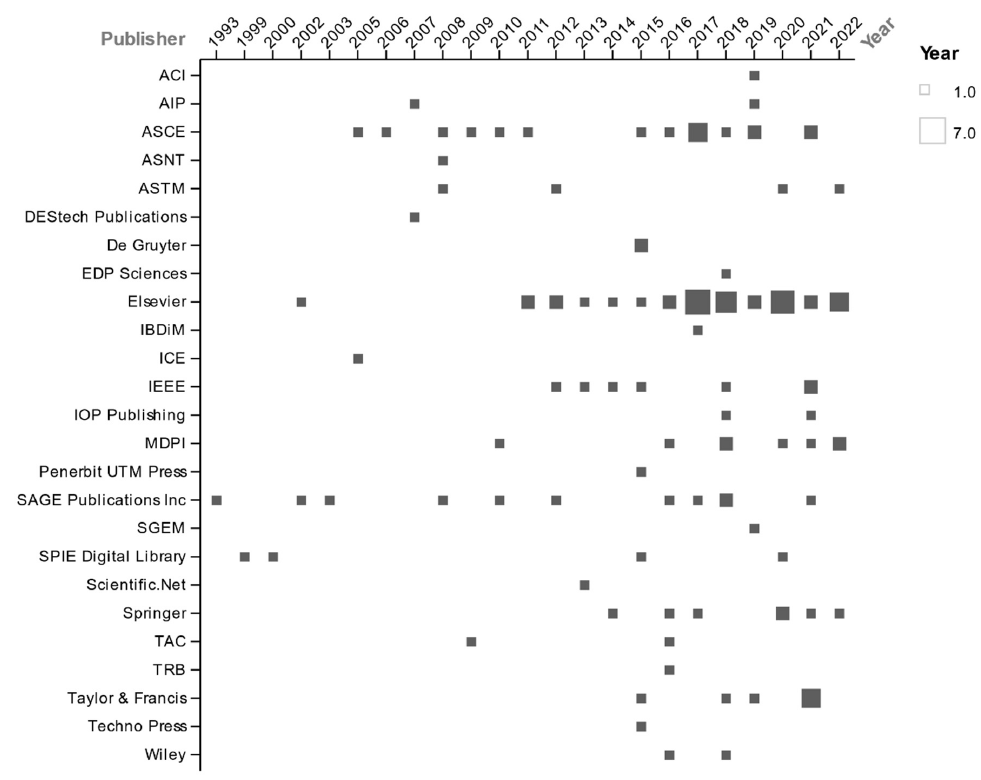
Figure 18. Number of relevant publications (122 selection) per publisher since 1993.